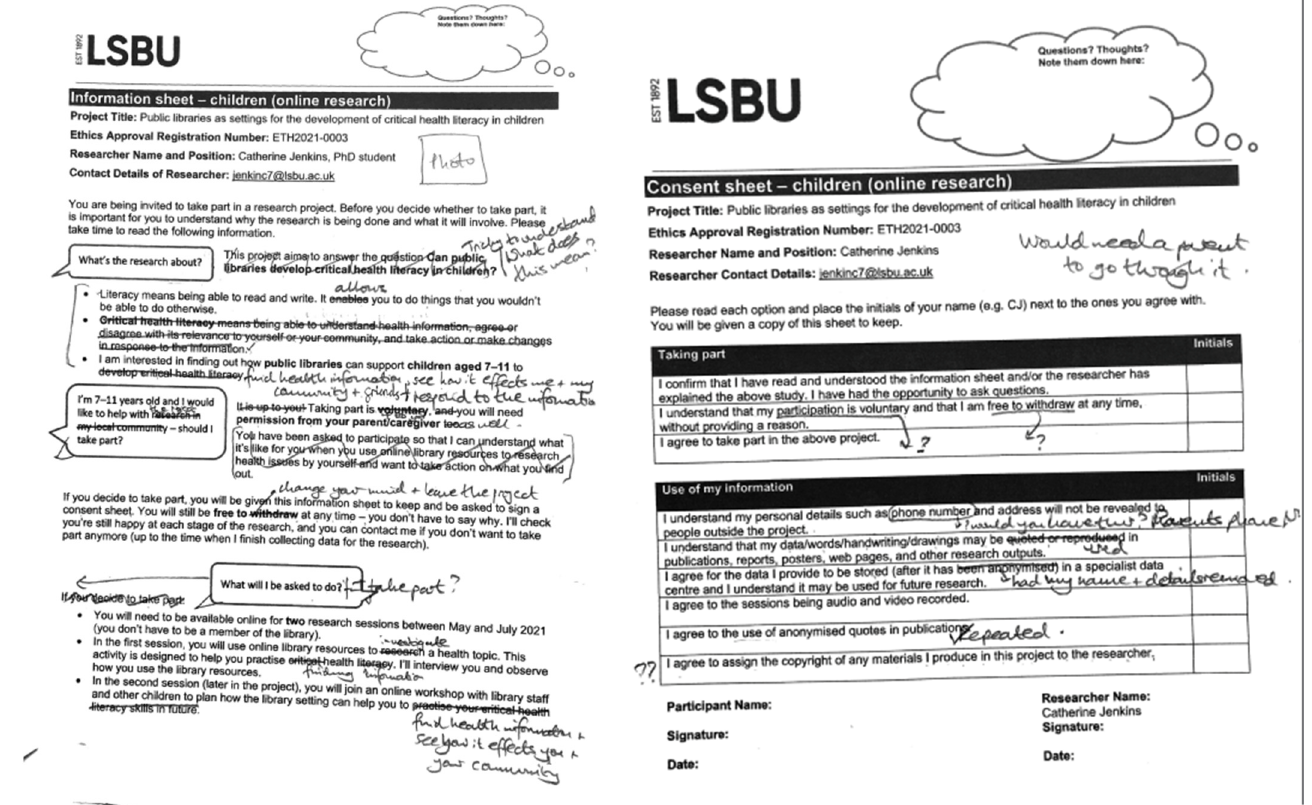
Figure 2. Edits by a Child Advisor dictated to, and transcribed by, their parent/caregiver. Edits included the use of ‘happy’, ‘confused/unsure’ and ‘not happy’ emoji against each consent clause and a ‘thought bubble’ space on the form where children could ex- pand on their reasons for selecting each emoji, or jot down any questions. However, these edits were transcribed by an adult, and were therefore presented at a remove from the child’s original feedback.